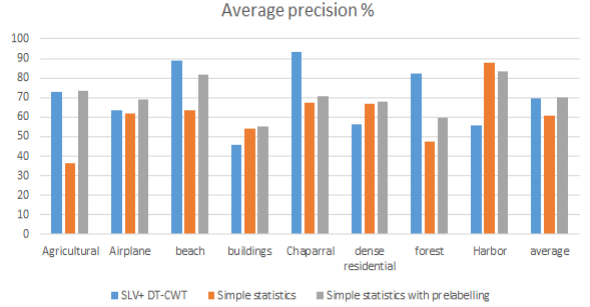
Figure 17. Average precision for each category.